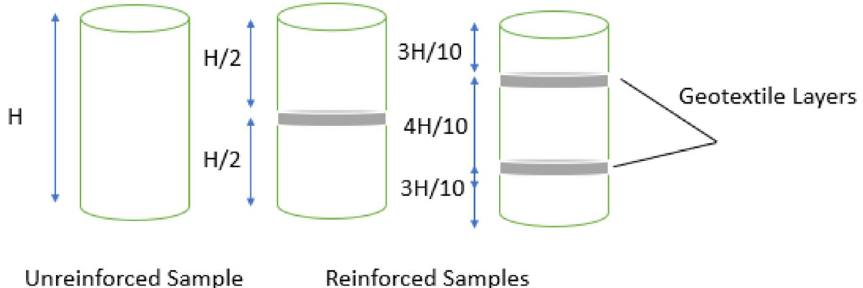
Fig. 4 Geotextile layers arrangement for silty sand samples